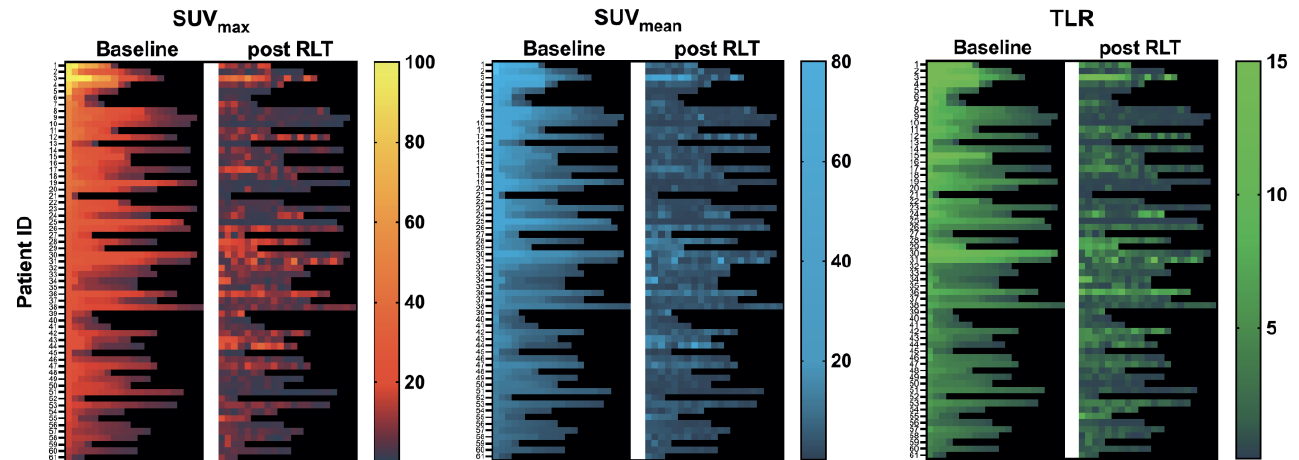
Figure 3. Heatmap of all assessed lesions: SUV max , SUV mean , and TLR at baseline and after RLT per patient. Rows correspond to treated patients sorted by intensity (baseline SUV max ) of the hottest lesion assessed; columns represent lesions sorted from hottest lesion (baseline SUV max ) per patient to coldest lesion (left to right).